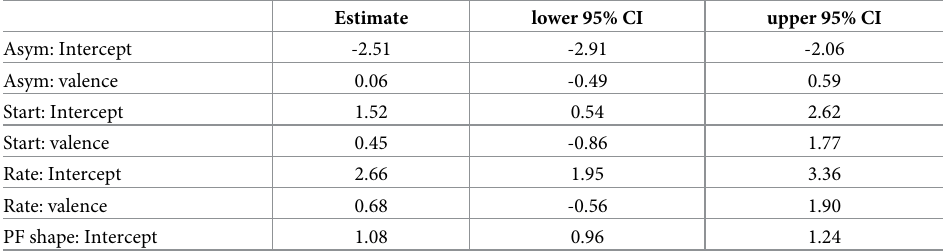
Table 4. Coefficient and CI from model testing valence-manipulation effects in adults. Estimate